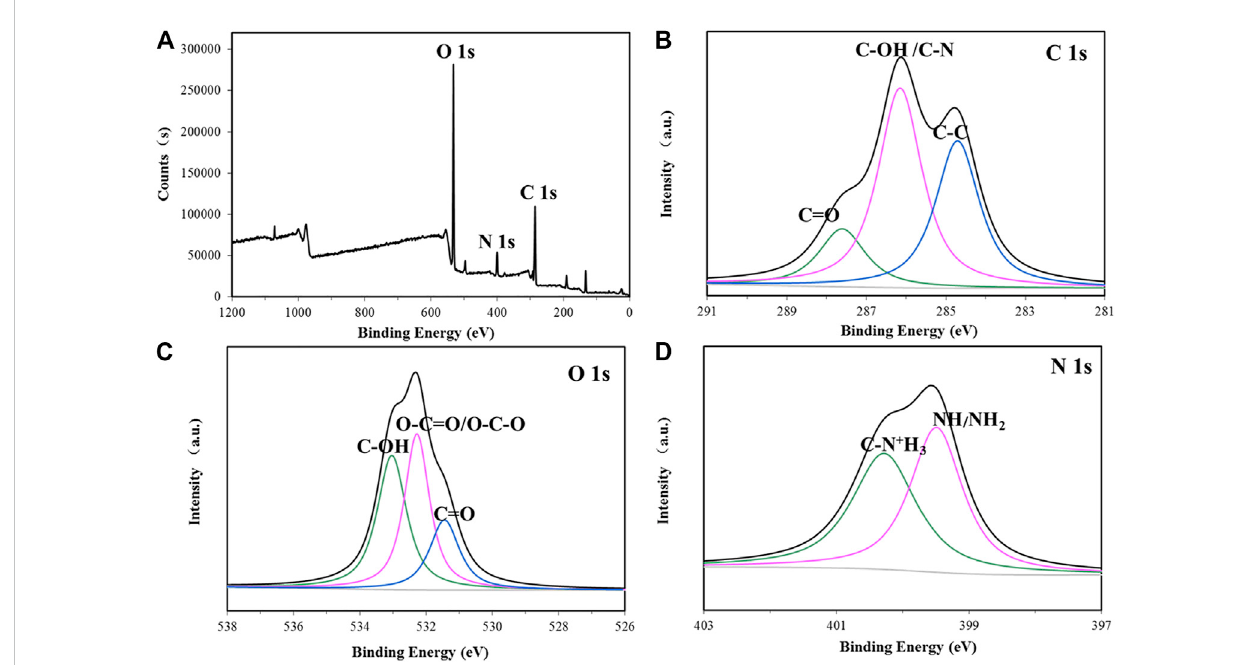
FIGURE 3 XPS spectra of the bio fl occulant (A) and high resolution 1 s XPS spectra of C, O, and N from P-GS408 are shown in (B – D) , respectively.